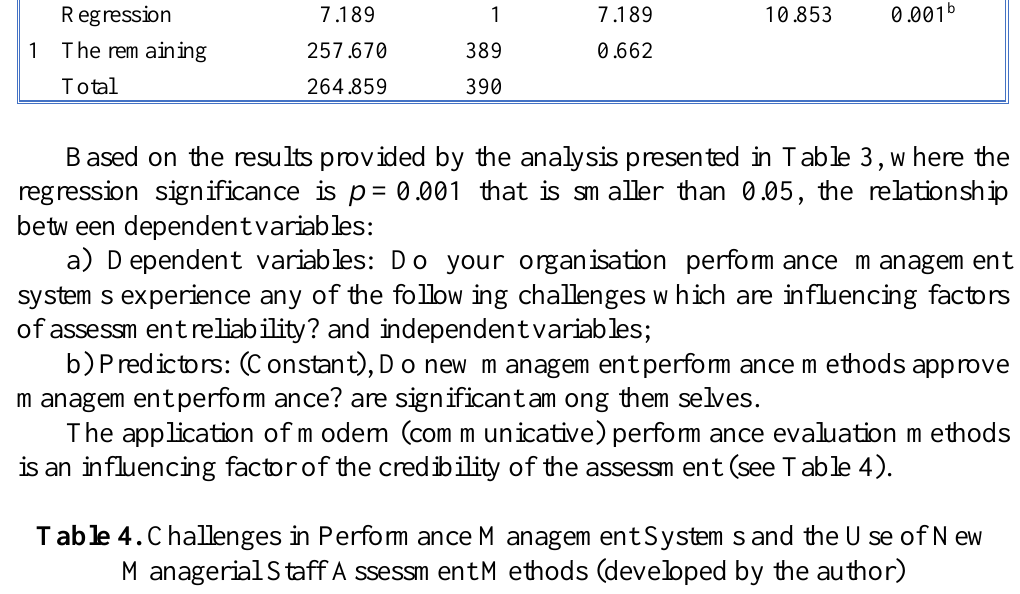
Table 4. Challenges in Performance Management Systems and the Use of